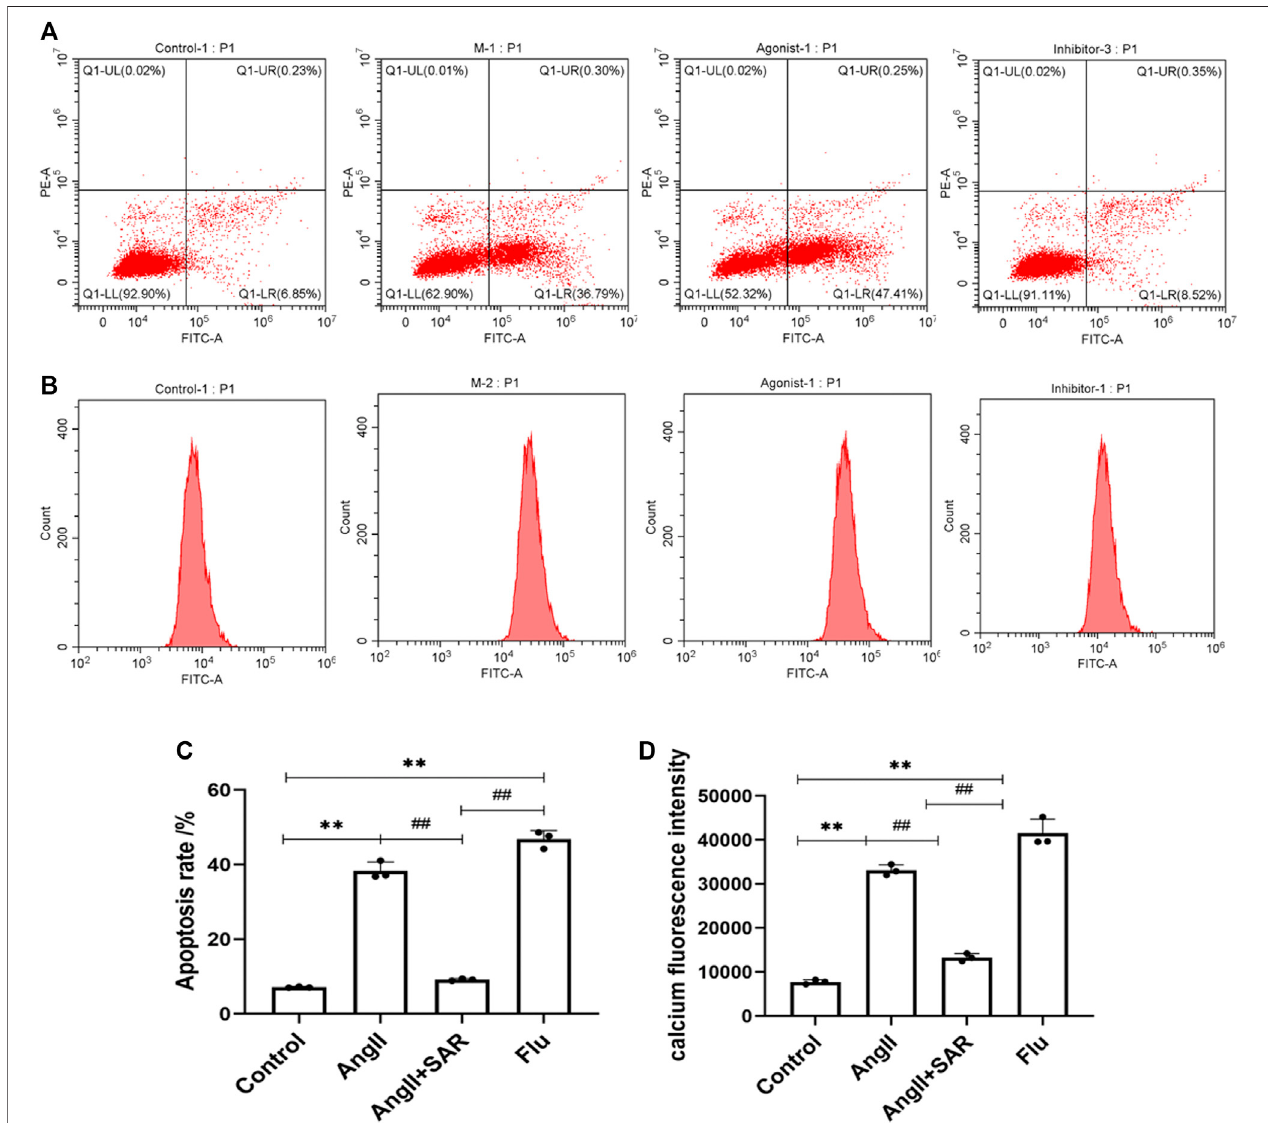
FIGURE7| Differencesinthepodocyteapoptosisrateandcalcium fl uorescenceintensityinnormalandunderdifferentdruginterventionsofAng,SAR,andFlu. (A) DifferencesinthepodocyteapoptosisrateinnormalandunderdifferentdruginterventionsofAng,SAR,andFlu.Q1wasthenecroticcell,Q2wasthelateapoptoticcell, Q3wastheearlyapoptoticcell,andQ4wasthenumberofviablecells. (B) Differencesincalcium fl uorescenceintensityinnormalandunderdifferentdruginterventionsof Ang, SAR, and Flu. (C) Quantitative plot of Figure (A) . (D) Quantitative plot of Figure (B) (Compared with the control group, ** p < 0.01; compared with the Ang Ⅱ group, ## p <